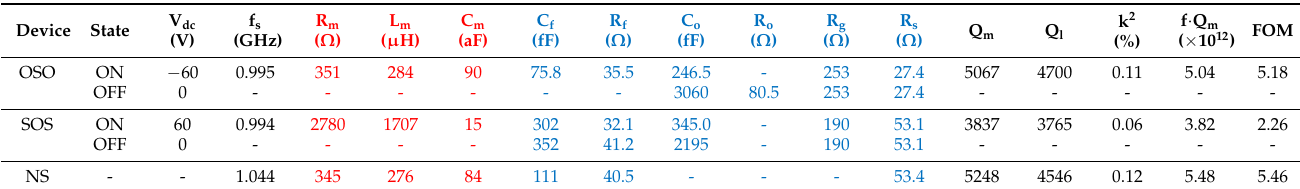
Table 1. Fitting parameters of the switchable transducers with control gate in ON/OFF states along with their non- switchable counterparts extracted from equivalent circuit models shown in Figure 5. Color coding coincides with the circuits shown in Figure